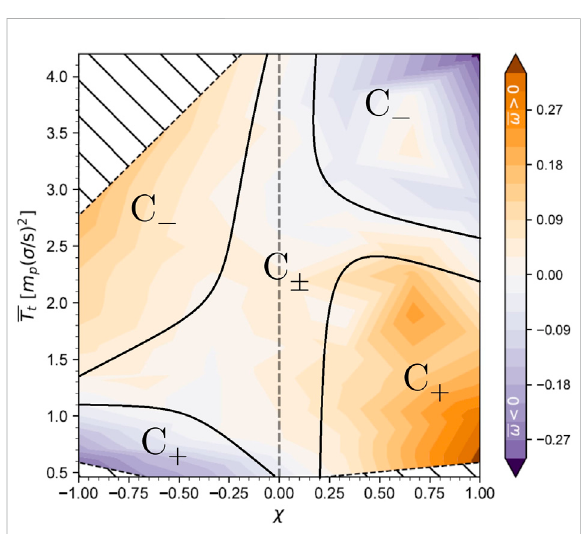
FIGURE 7 Average fl ow vorticity 2D diagram. The sense of chiral fl ow (sign of (cid:1) ω ) is indicated by a color gradient, orange means positive vorticity ( (cid:1) ω > 0 ) , white, (cid:1) ω (cid:2) 0, being the complex phase ( C ± ) , and purple means negative vorticity. The y-axis represents mean kinetic energy (controlled by the air fl ow velocity) and x-axis, χ , is the relative density fraction of the species, with χ = − 1 being a systemcomposedonlyofspecies-1 particlesand χ =+1onlykind- 2 spinners. We have signaled approximately (solid black lines plus labels) the chiral phase each region represents (phase depends on a combination of the signs (cid:1) ω and χ